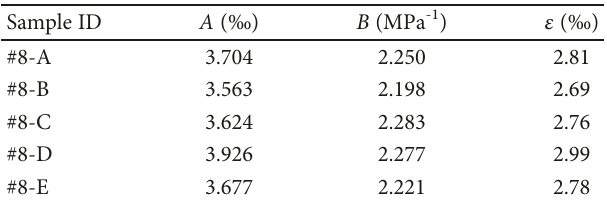
V P and S . Table 4: Adsorption deformation constant and quantity of coal